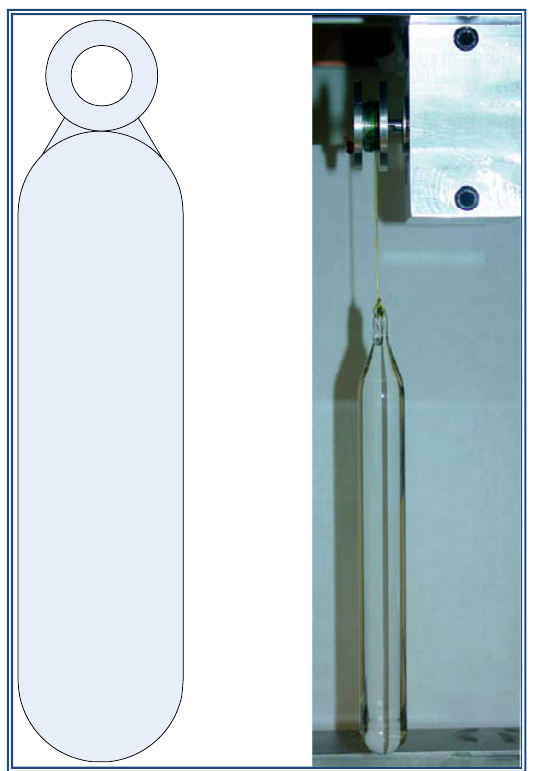
Figure 5. Sinker tied to a stepper